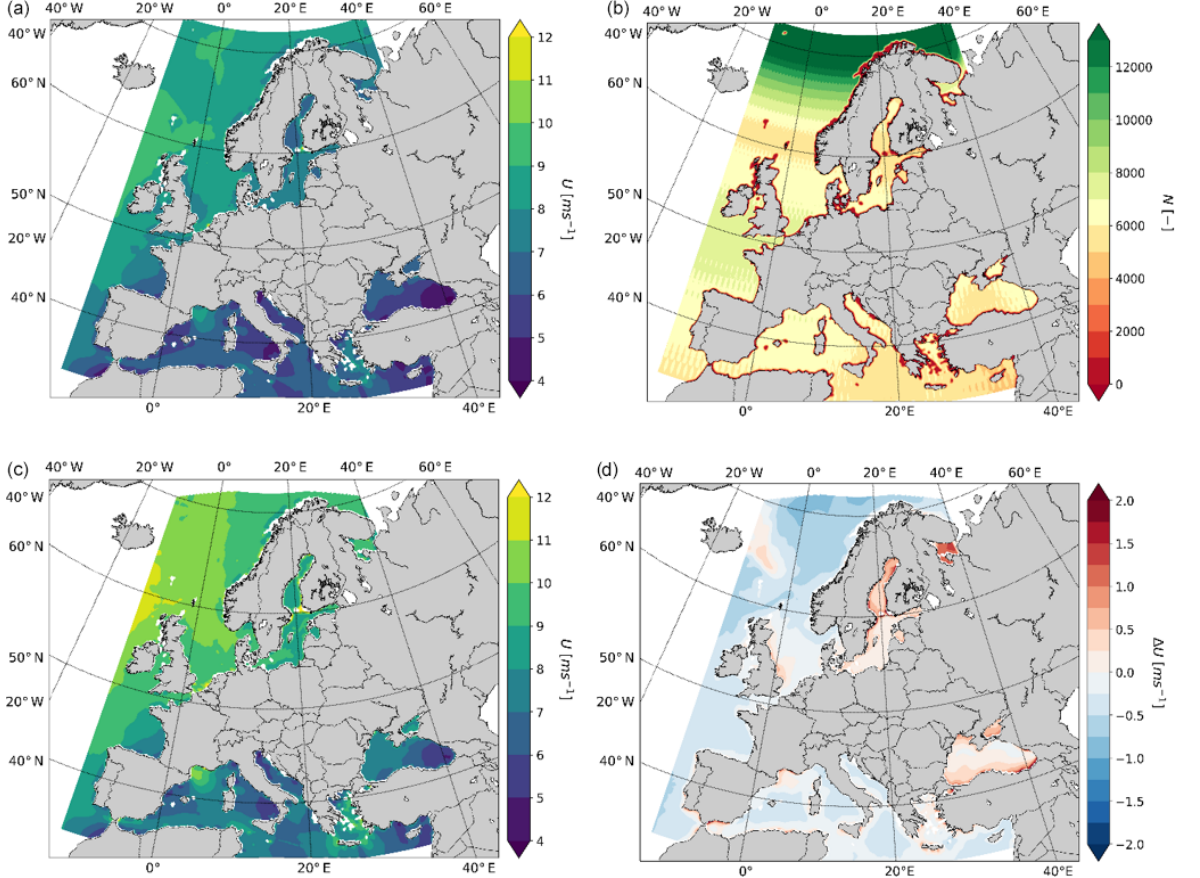
Figure 2. For ASCAT the mean wind speed (ms − 1 ) at 10m height (a) , number of samples (b) , mean wind speed at 100m including long- term stability correction for extrapolation (c) and difference in wind speed at 100ma.m.s.l. height based on long-term stability correction minus neutral wind profile assumption (d) are